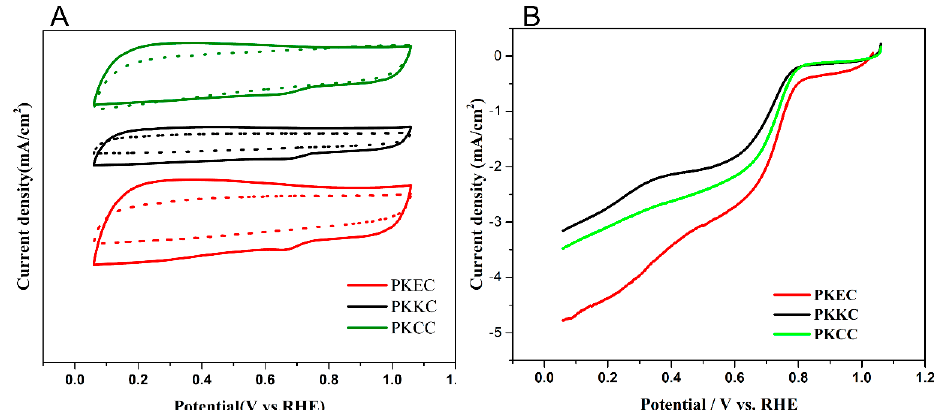
Figure 1. Electrochemical measurements of algal biomass derived catalysts on an RDE. ( A ) CV curves of PKEC, PKCC and PKKC in O 2 -saturated (solid lines) or N 2 -saturated (dotted lines) 0.1 M KOH aqueous solutions at a scan rate of 100 mV/s. ( B ) LSV curves of above three catalysts in O 2 saturated 0.1 M KOH at a sweep rate of 10 mV/s and rotation speed of 1600 rpm. Catalyst loading: 0.2 mg/cm 2 .